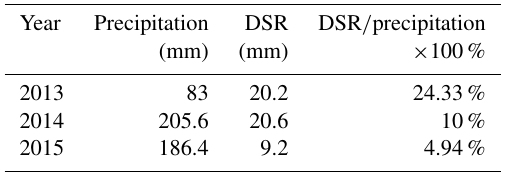
Table 1. The annual precipitation–DSR relationship from 2013 to